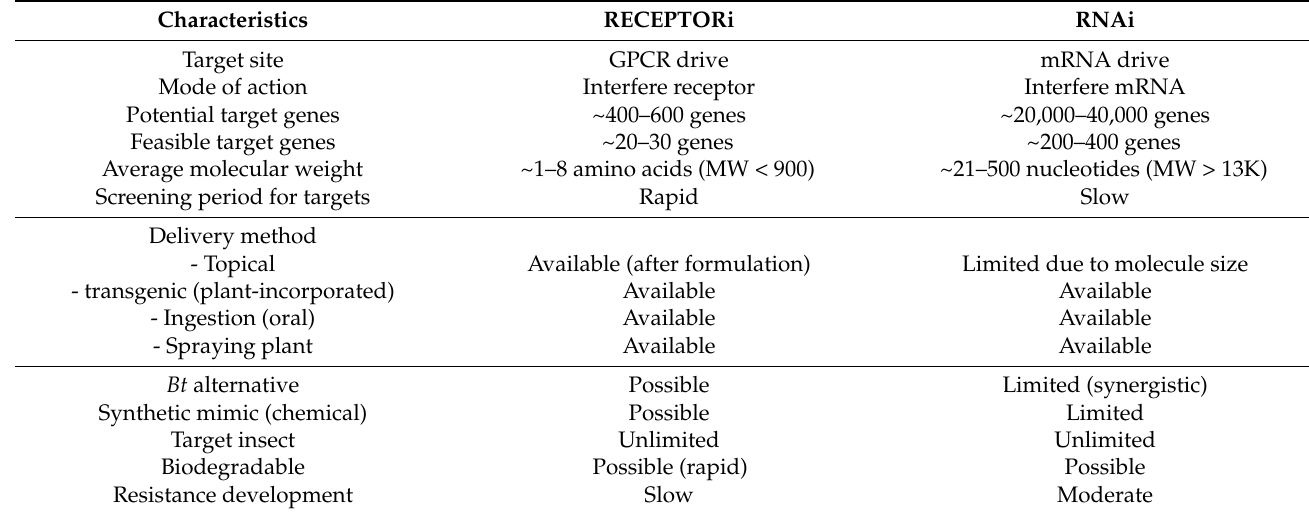
Table 2. Comparison of RECEPTORi and